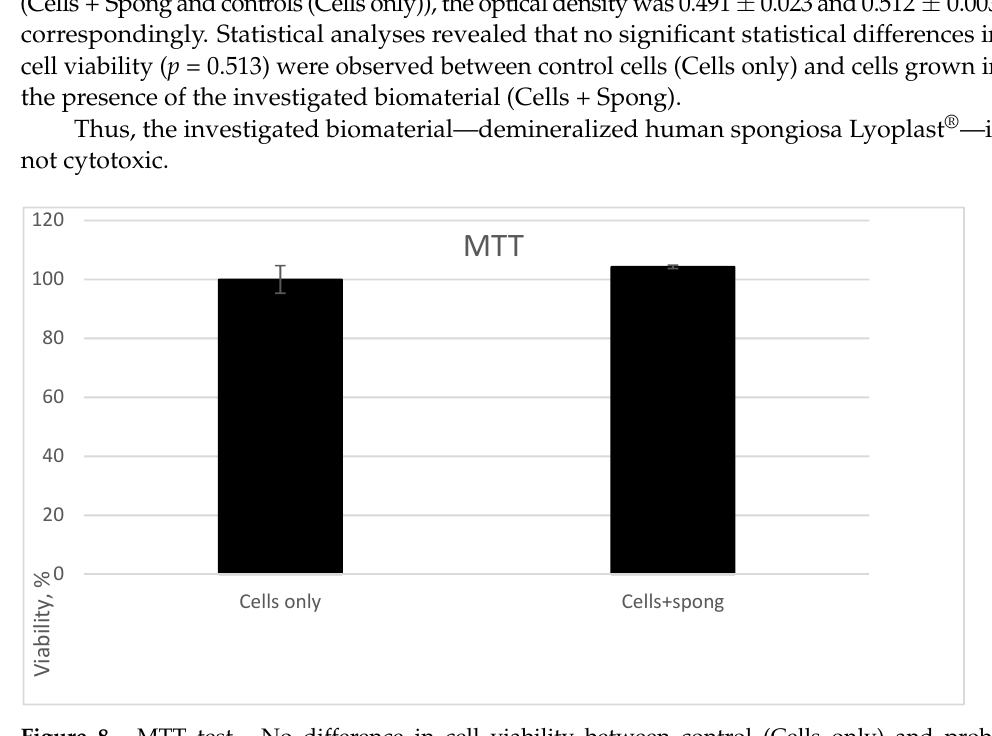
Table 2. MTT test. Indicators of optical density in experimental and control wells.